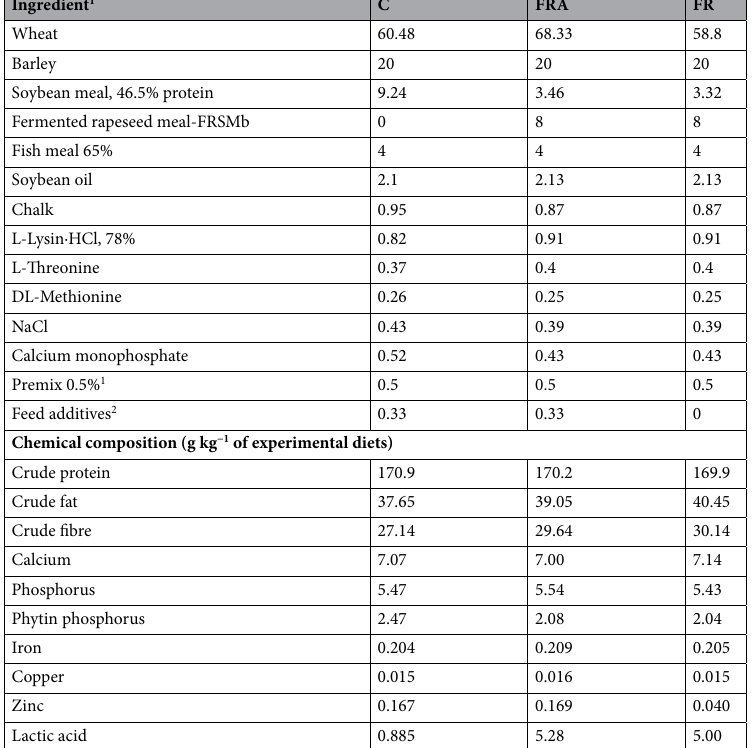
which can hydrolyse pectic substances (0.10 g); Saccharomyces cerevisiae (0.20